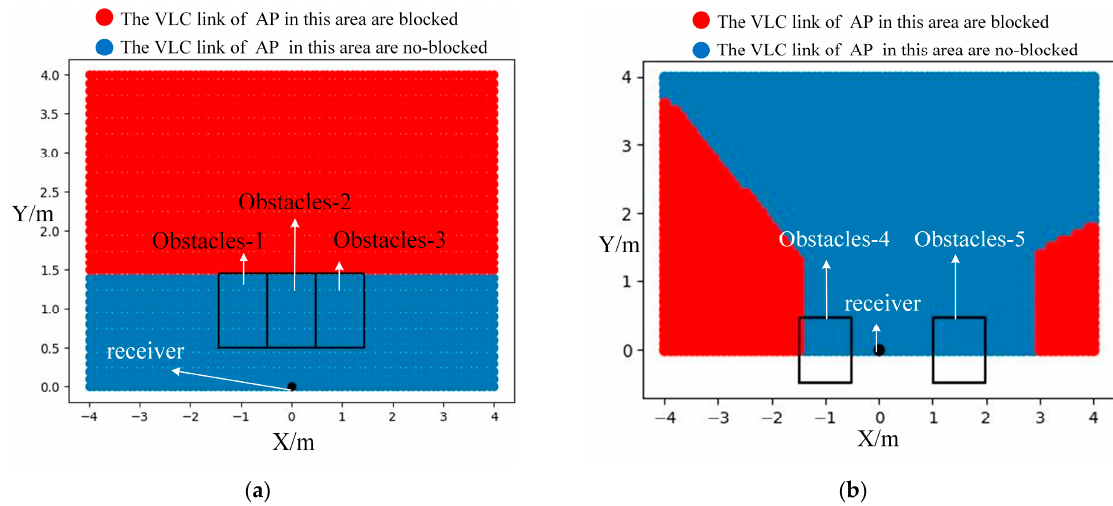
Figure 7. Theoretical value of link state obtained by link-blockage model: ( a ) link state of APs under the influence of static obstacles; ( b ) link state of APs under the influence of dynamic obstacles.